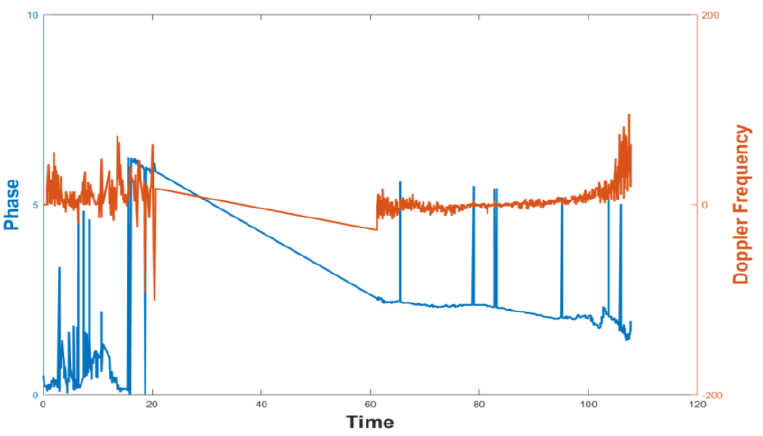
Figure 7. Data of Phase and Doppler Frequency.